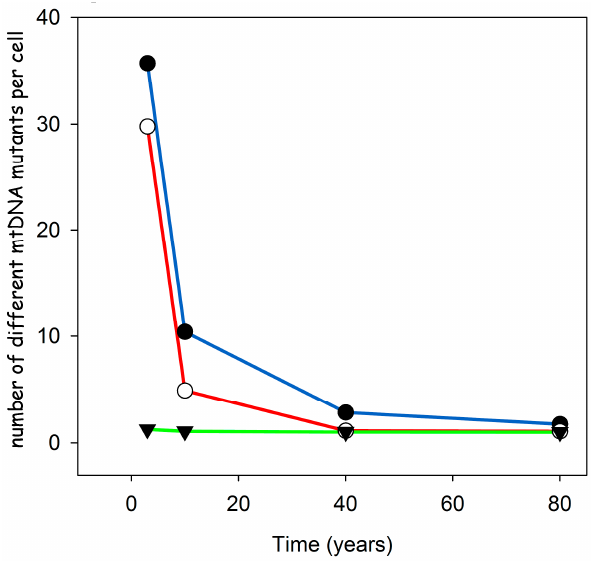
Figure 5. Results of stochastic computer simulations for different species lifespans and different hypotheses (filled circles: random drift, open circles: smaller genome size, filled triangles: replication via transcription) explaining the accumulation of deletion mutants. Only the idea that replication is controlled via a transcriptional feedback leads to the low level of heteroplasmy observed in short lived species. Modified from [10].